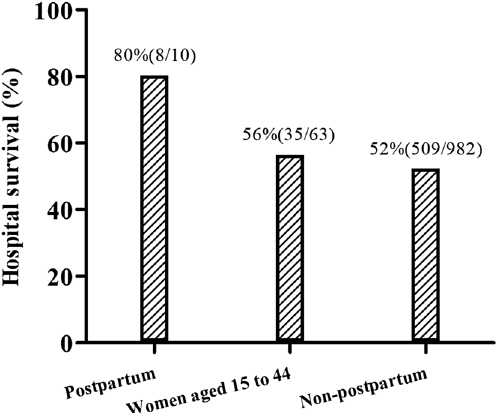
Figure 4. Hospital survival of patients: the survival of postpartum patients was significantly better than that of female patients with age between 15 to